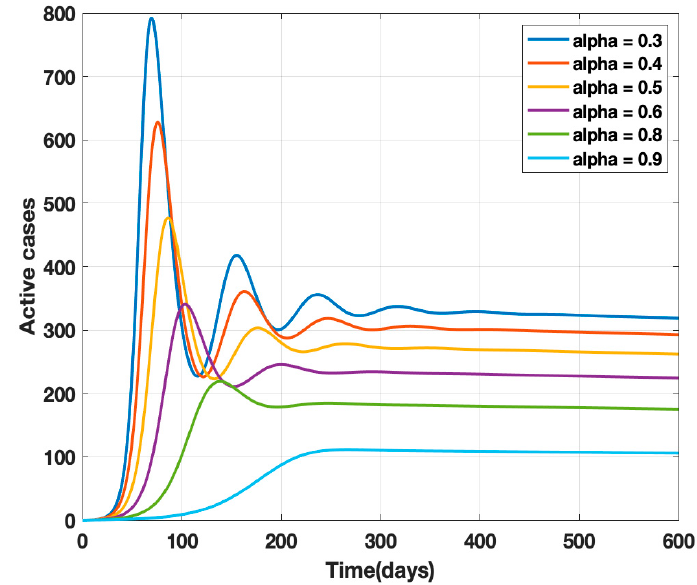
Figure 4. Sensitivity analysis of α and k for α = 0.3, 0.4, 0.5, 0.6, 0.7, 0.8, and k = 100, ρ − 1 = 10 days 0.5, 0.6, 0.7, 0.8, and k = 1000, ρ − 1 = 10 days.